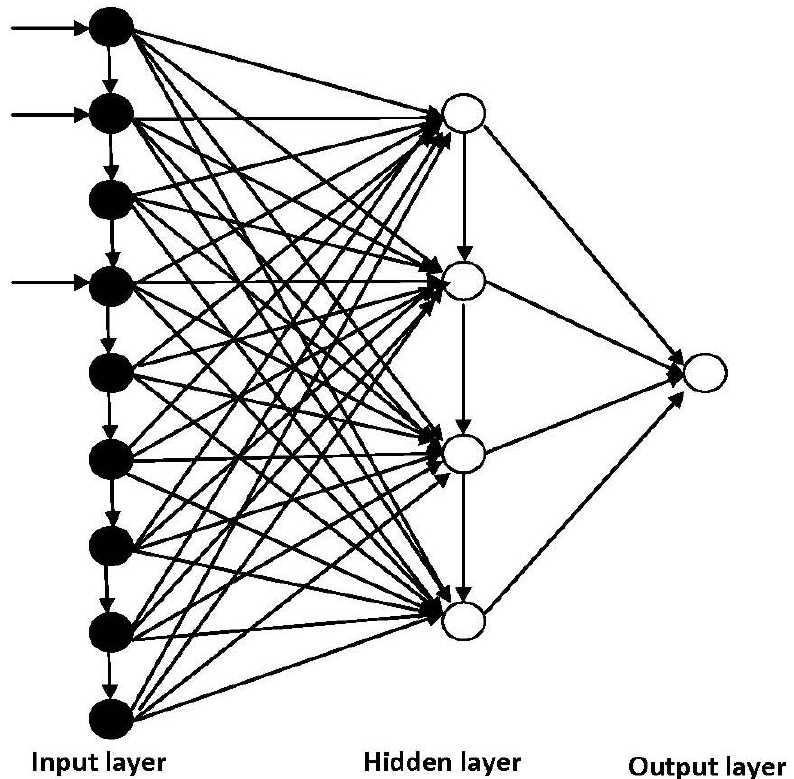
Figure 1. Schematic of the initial artificial neural network